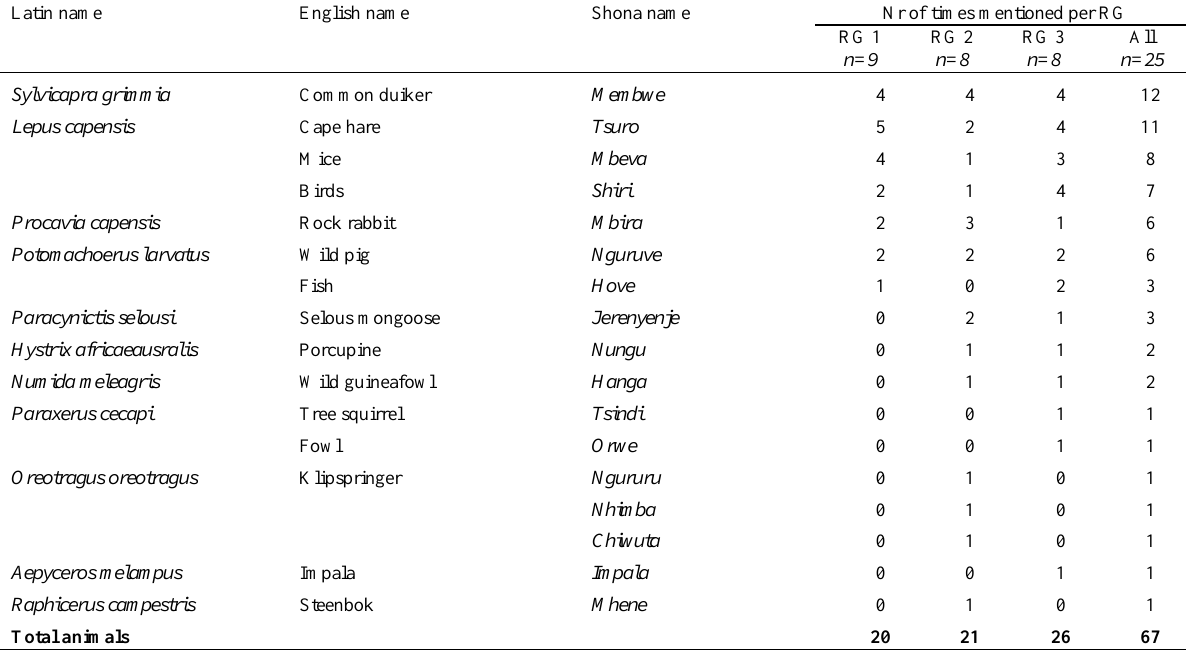
Table A3.7: Wild animals, species names and collection